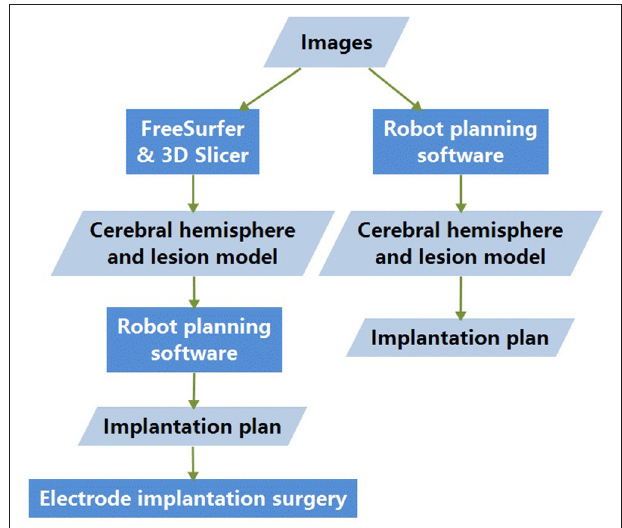
FIGURE 1 | Basic research process. Images are processed with both methods 1 and 2; the difference lies in the cerebral-hemisphere and lesion-model generation. The electrode-implantation surgeries were conducted based on the model and implantation plan designed with method